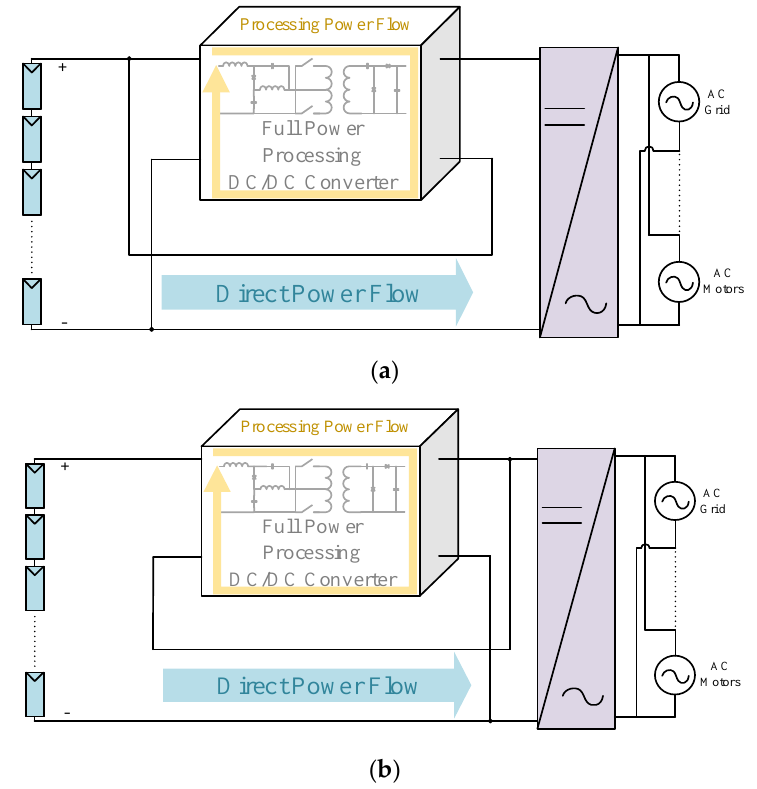
Figure 1. Basic structure of partial power processing (PPP system): ( a ) Input parallel output series, ( b ) Input series output parallel.